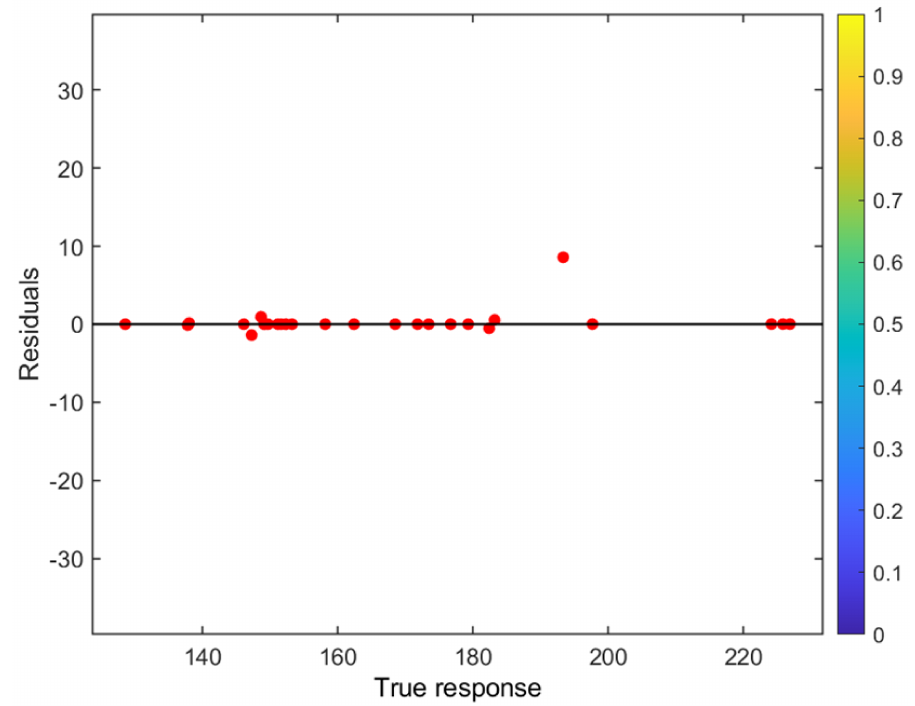
Figure 8. Errors in prediction